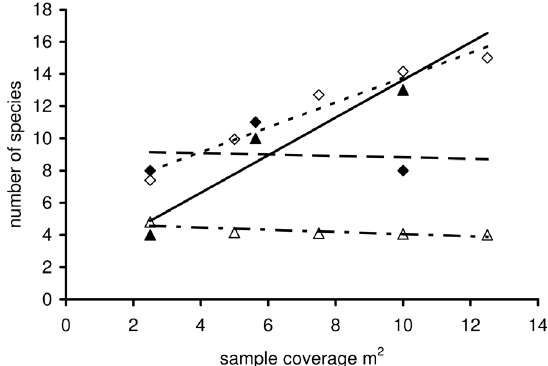
Figure 4. Case 5. Sample intensity. Response of the number of satellite species and the number of core species to changes in size and number of sample units (quadrats) within the same sample coverage. Legend: response of the number of satellite species to change in quadrat size ( ♦ – – –, y = –0.04x + 9.27, R 2 = 0.009) and number of quadrats ( ◊ - - -, y = 0.77x + 6.02, R 2 = 0.956); response of the number of core species to change in quadrat size (  –––, y = 1.16x + 1.94, R 2 = 0.920) and number of